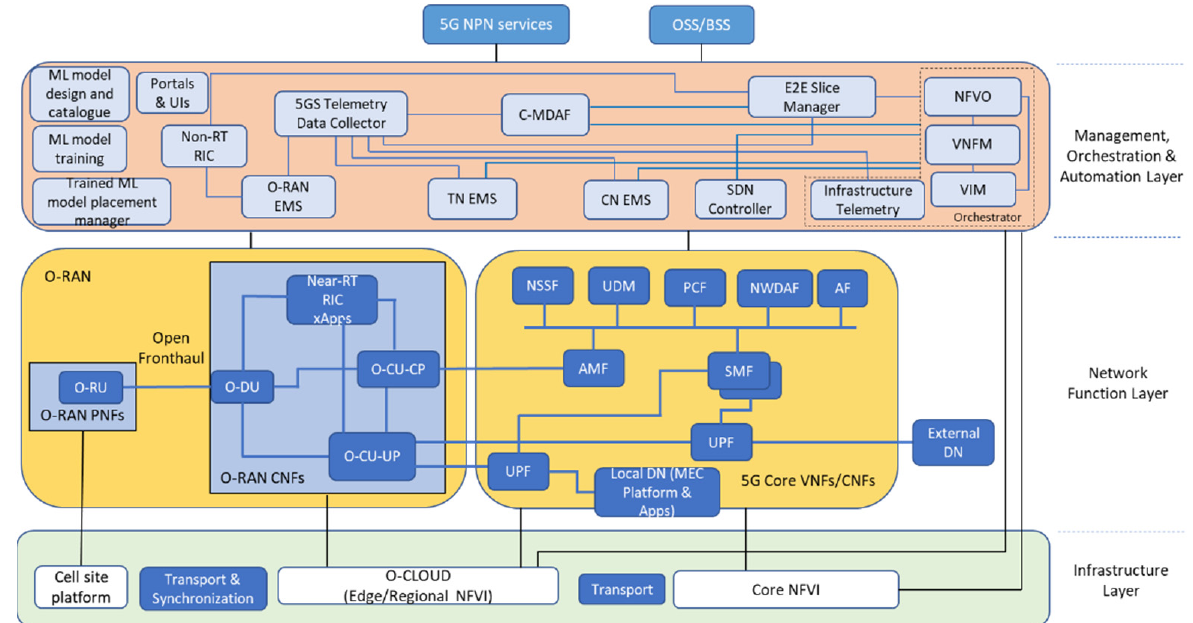
Figure 2. Conceptual approach of the proposed architectural concept.